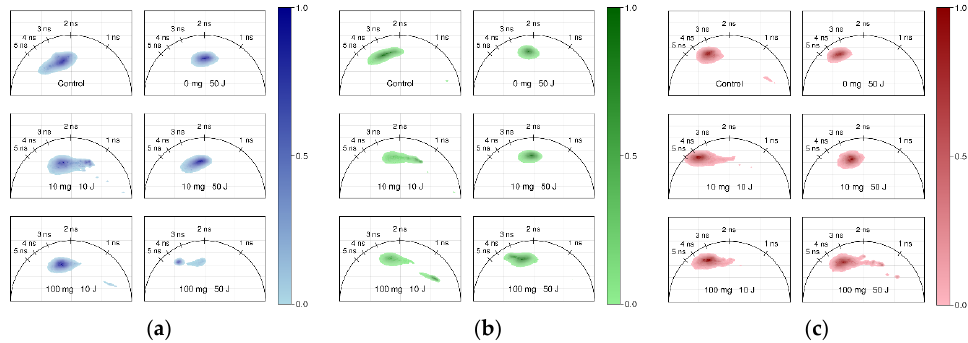
Figure 9. Phasor diagrams for time-resolved fluorescence images of tumor slices after ALA–PDT in the spectral bands of NADH ( a ), flavins ( b ) and PpIX ( c ).